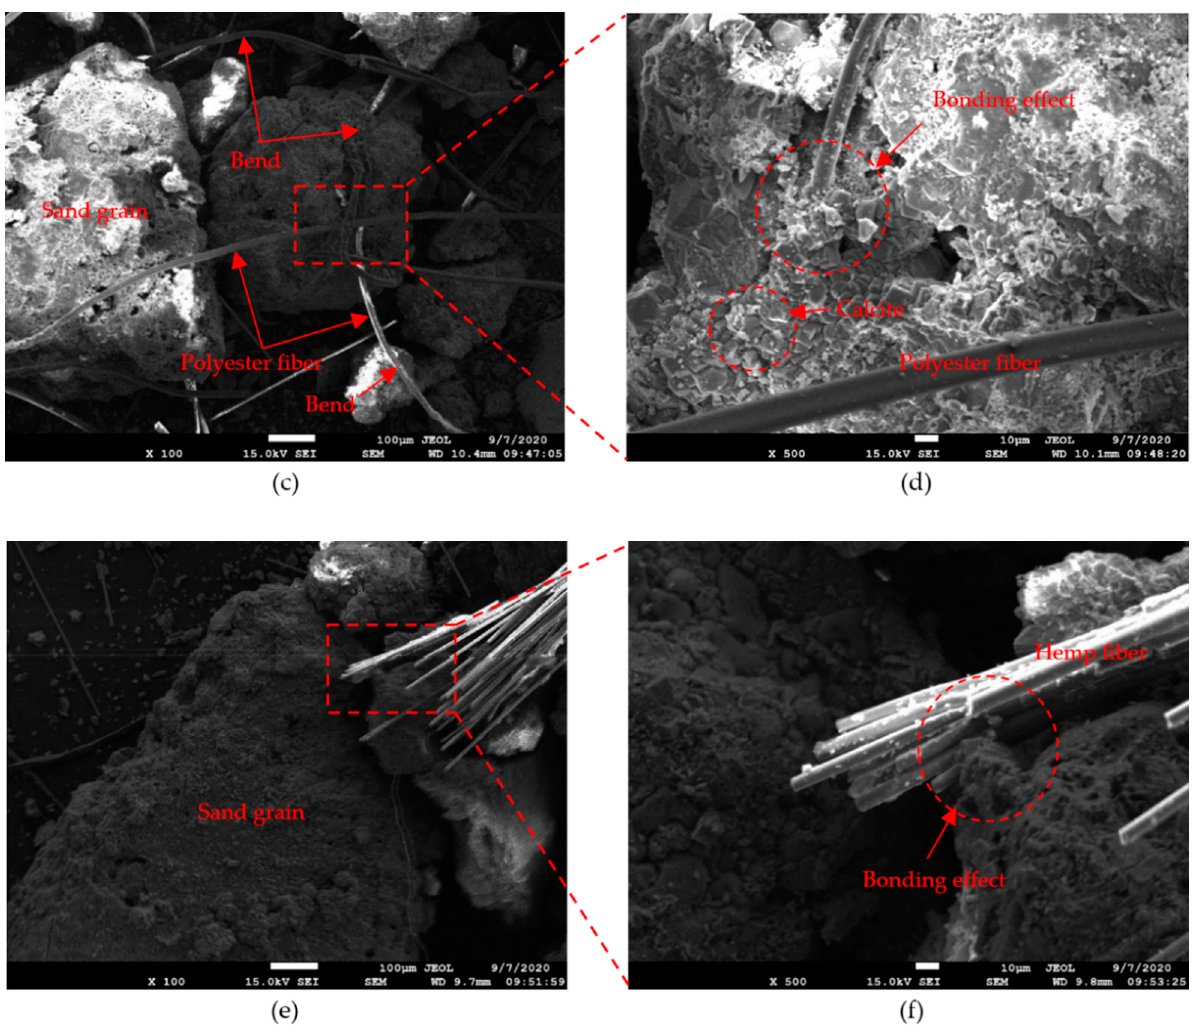
Figure 14. SEM images of sand after MICP reinforcement of 0.2% glass fiber at ( a ) 100× and ( b ) 500× magnification; 0.25% polyester fiber at ( c ) 100× and ( d ) 500× magnification, and 0.25% hemp fiber at ( e ) 100× and ( f ) 500× magnification.